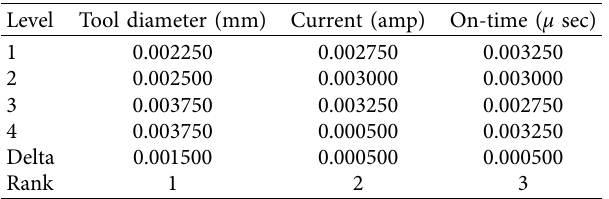
Figure 4: Tools used for EDM process. Table 2: Larger S/N ratio Taguchi method. Table 3: Response table for